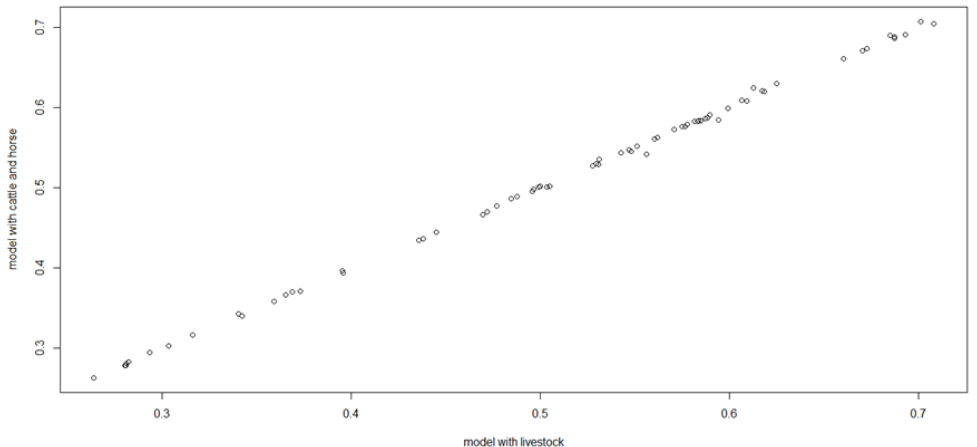
Figure A4. Correlation between the results (fitted values of grassland NDVI) of the models with separate variables for cattle and horse densities (whose results are shown in the main text) and those pooling these densities in a single variable named “livestock” (used to produce the prediction plots shown in the lowest panels of Figure 5).